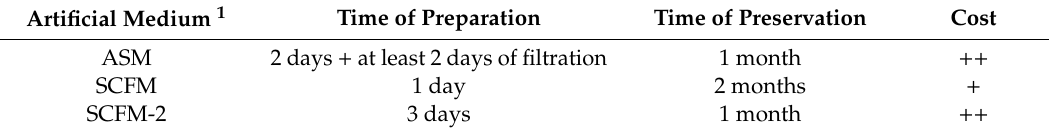
Table 2. Preparation, preservation, and cost of the artificial media used in this study. Artificial Medium